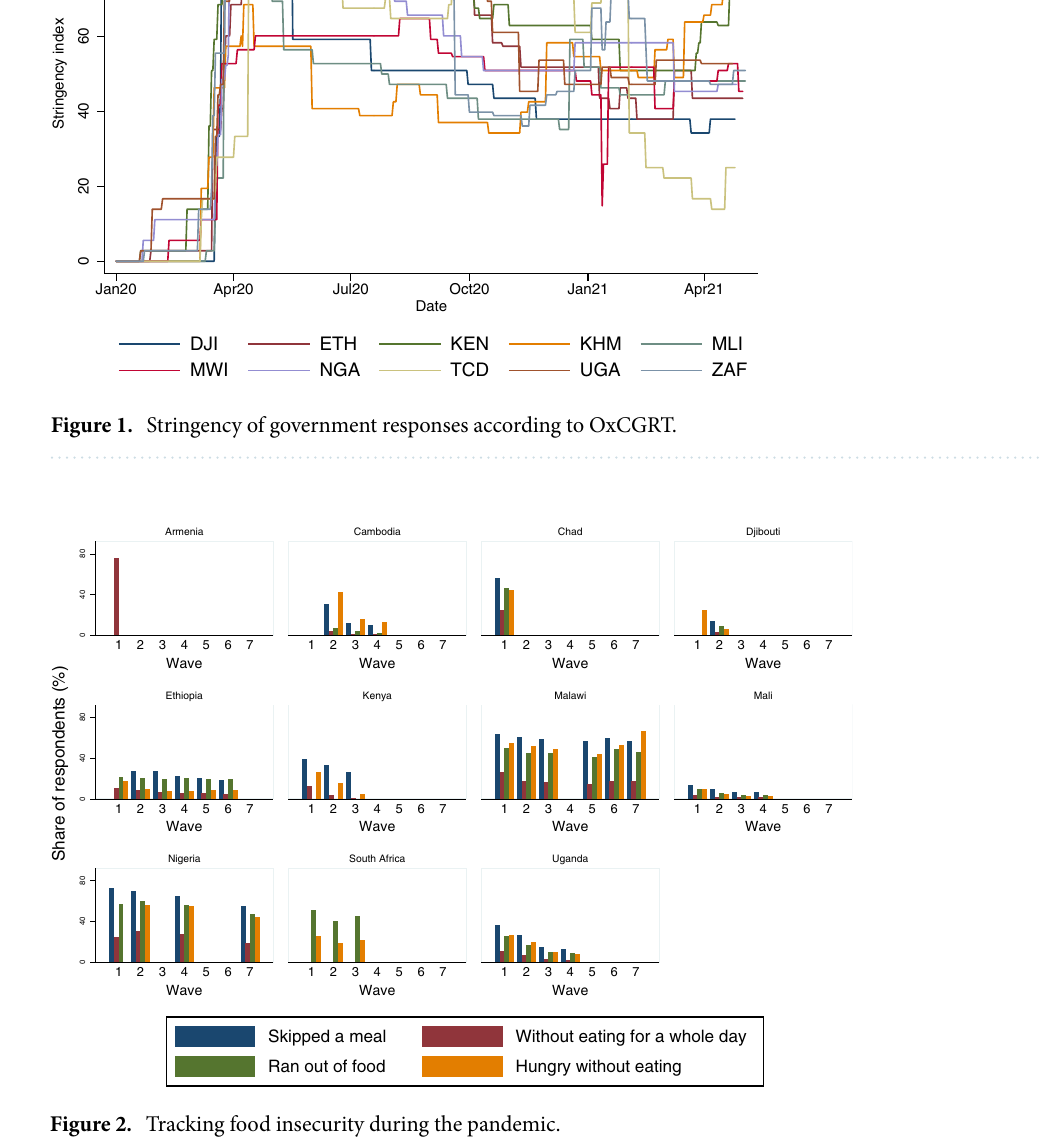
Figure 2. Tracking food insecurity during the pandemic.